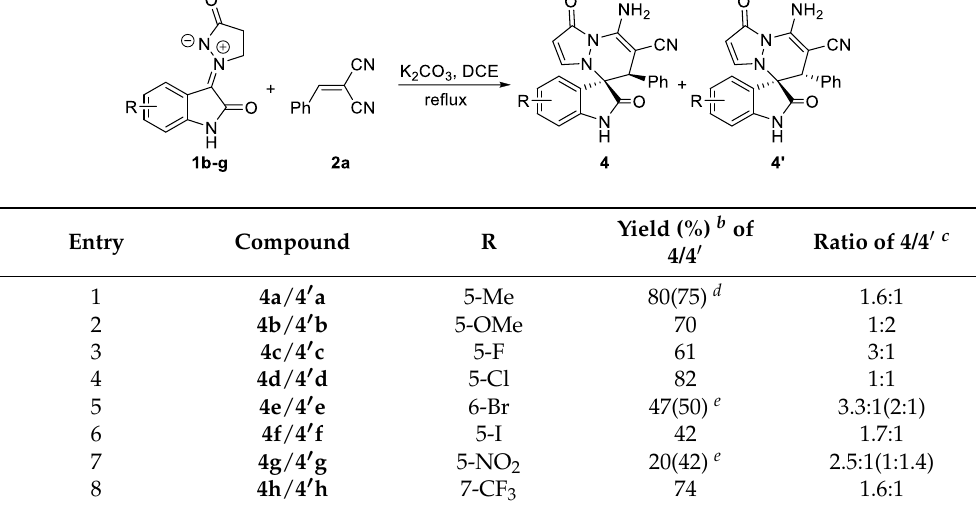
Figure 2. The phenomenon of the reaction for 1a and 2a under K 2 CO 3 in DCE at reflux and TLC analysis: ( a ) no K 2 CO 3 (0 h) (a light red cloudy solution); ( b ) added K 2 CO 3 (3 h) (a clarified luminous yellow solution); ( c ): reaction finished (4 h) (a dark green solution).